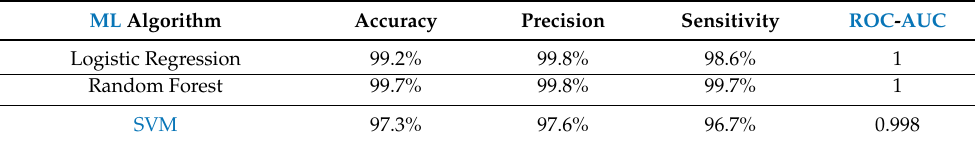
Figure 7. Distribution plot for loneliness index in the simulated scenario with dummy data. Table 6. Results of ML algorithms for conceptual model of loneliness